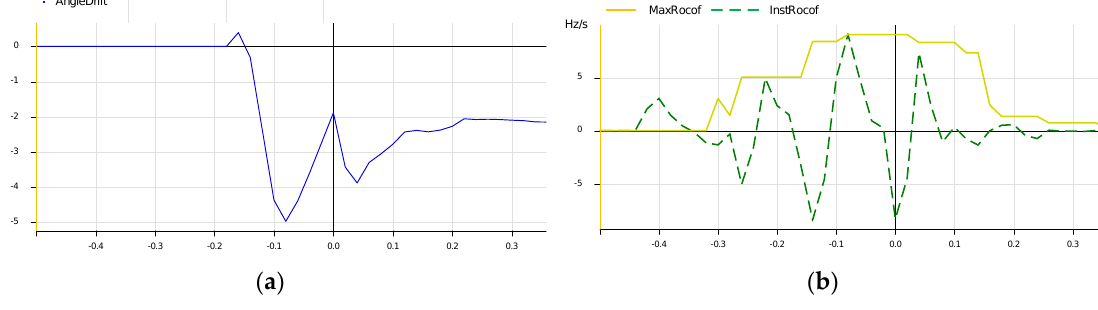
Figure 14. ( a ) Phase angle drift; ( b ) maximum and instantaneous ROCOF values during the three-phase fault.